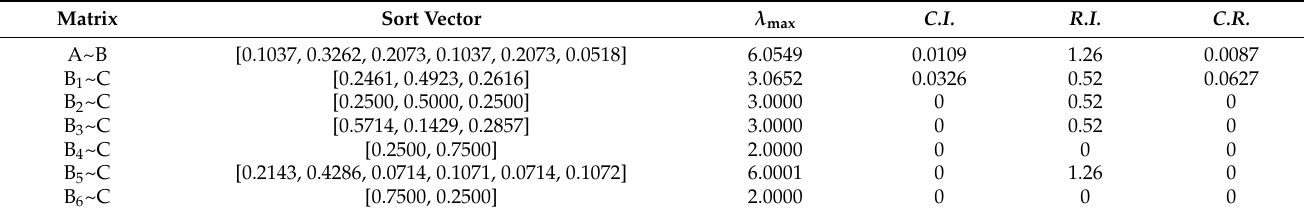
Table 5. Results of consistency test of the experts’ scores.